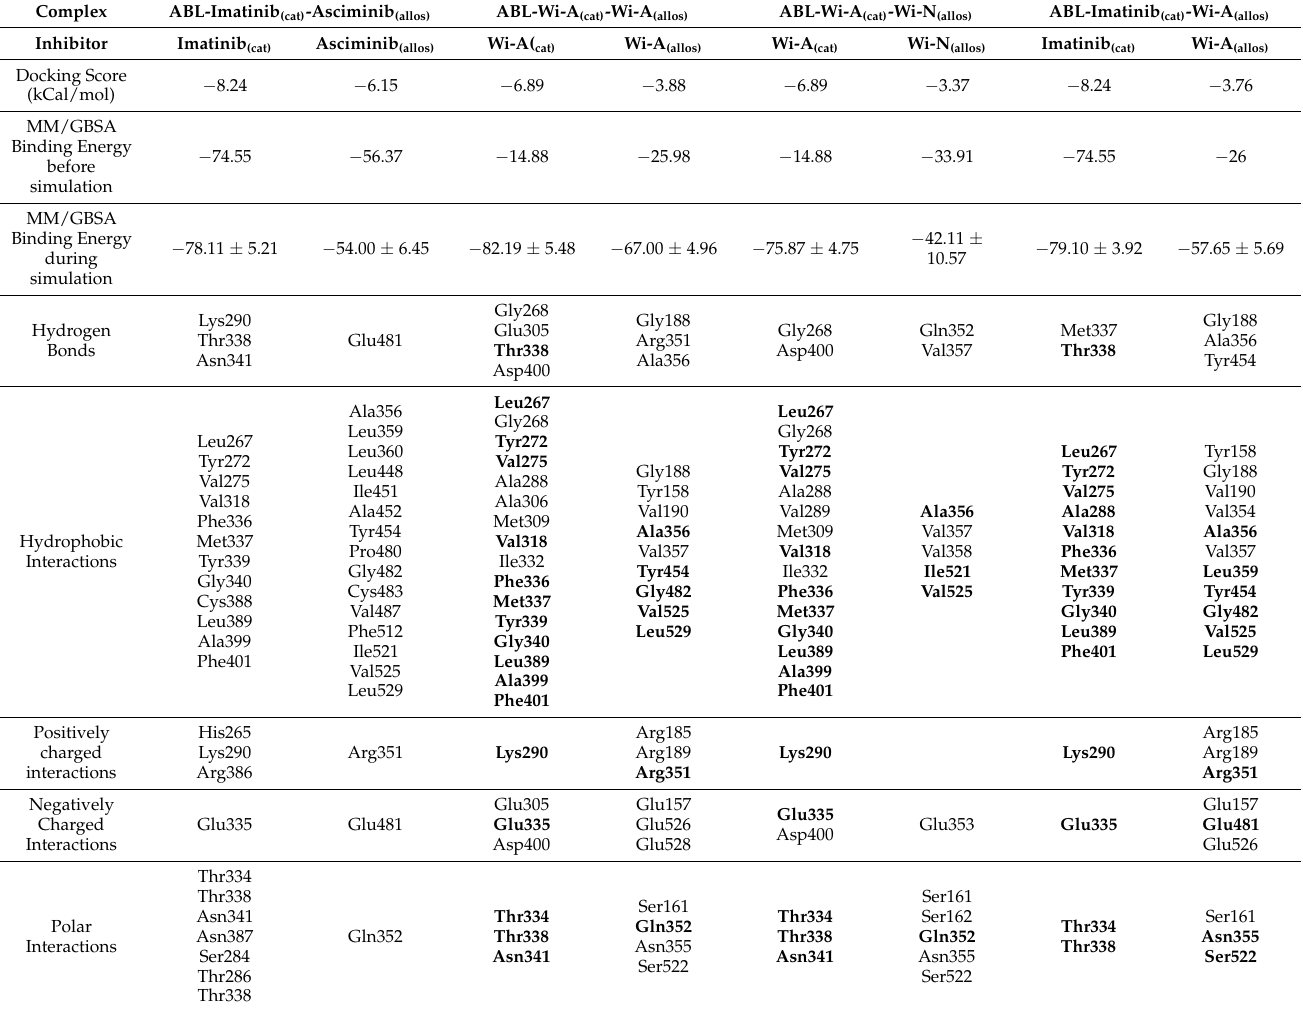
Table 2. Binding energies and interactions formed by inhibitors at catalytic and allosteric site of ABL-Imatinib (cat) -Asciminib (allos) complex (treated as control), ABL-Wi-A (cat) -Wi-N (allos) complex, ABL-Wi-A (cat) -Wi-A (allos) complex and ABL-Imatinib (cat) -Wi-A (allos) complex. Interactions formed by Wi-A and Wi-N similar to our control inhibitors are highlighted in